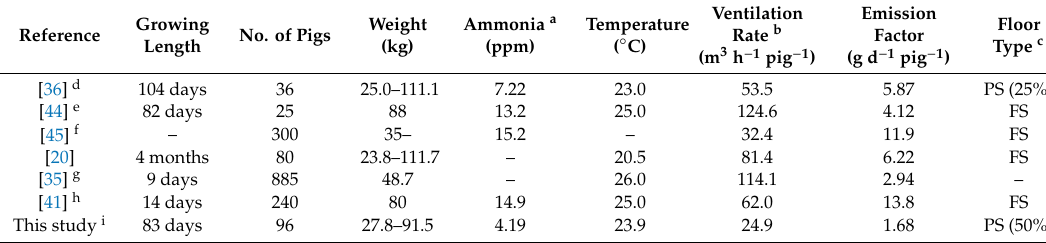
Table 6. Comparison of pig farm characteristics and results of this study with that of other published studies. Growing length, number, and weight range of pigs, and ammonia concentration, temperature, ventilation rate, ammonia emission factor, and flooring type of finishing swine farms using a mechanical ventilation system are compared.